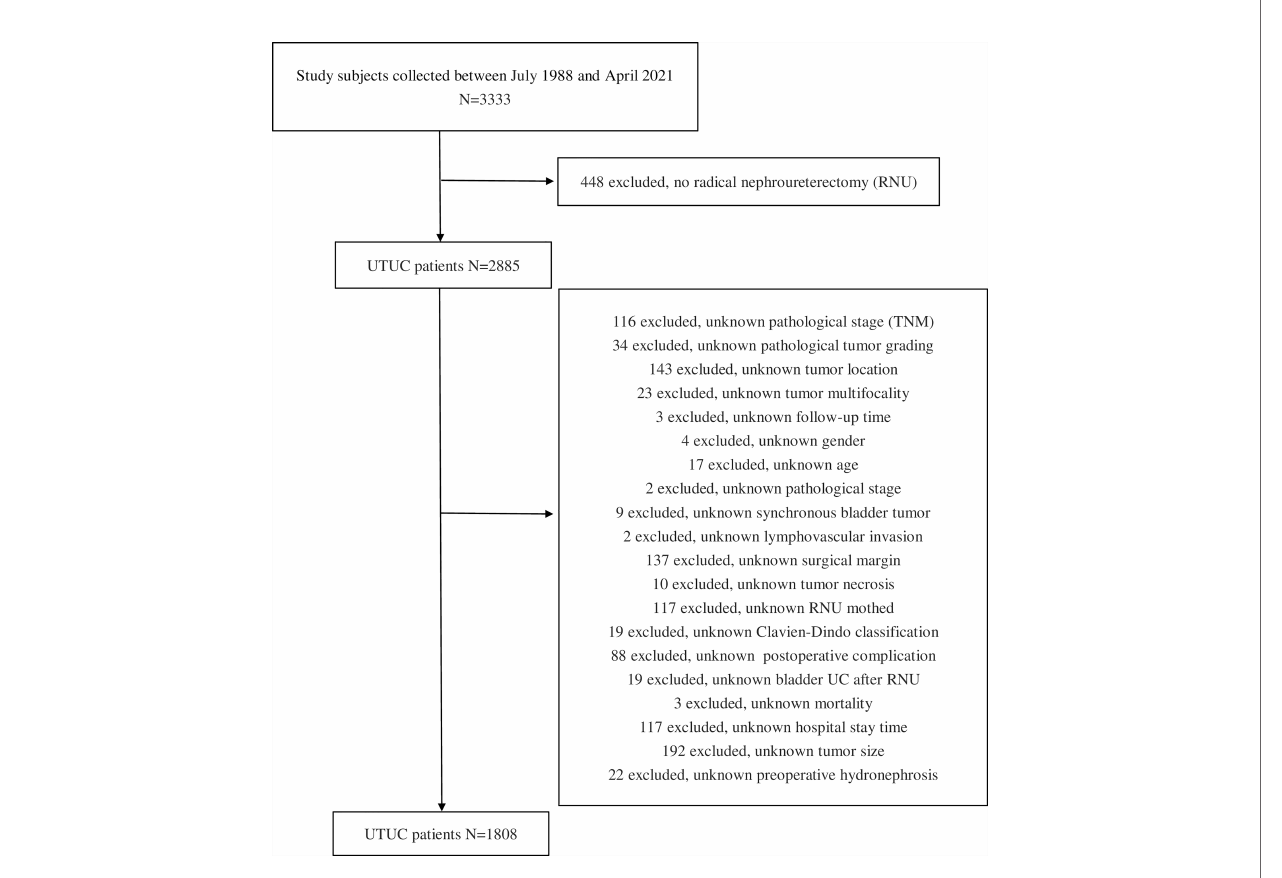
FIGURE 1 | Study fl